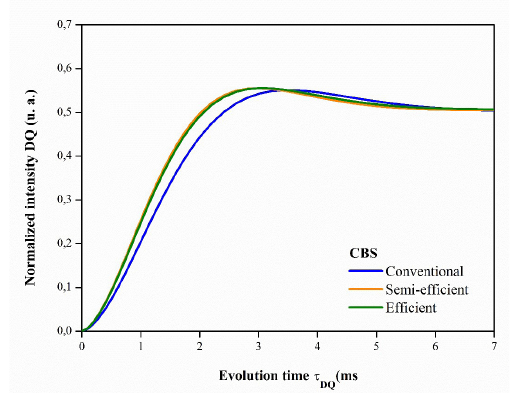
Figure 6. Normalized magnetization accumulation curves for vulcanized NR compounds and those accelerated by MBTS in their respective crosslinking systems.